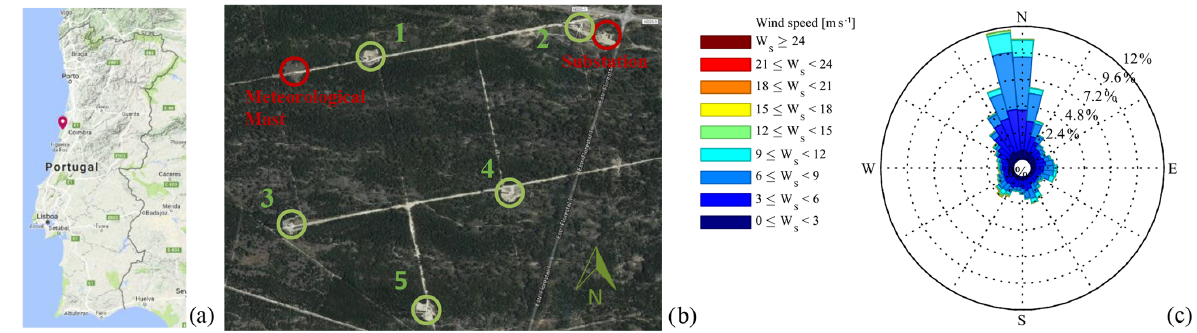
Figure 2. Tocha wind farm: (a) geographic location in Portugal (© Google, 2018a), (b) identification of wind turbines and auxiliary structures (© Google, 2018b), (c) characterization of the wind conditions observed in 2017 (SCADA data of WT1).